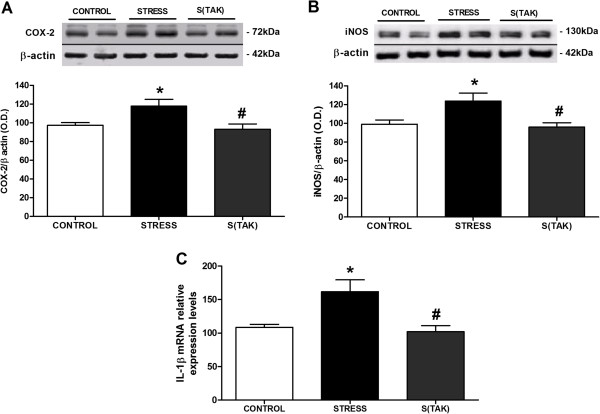
Anti-inflammatory effects of systemic TAK-242 after stress exposure in rat brain frontal cortex. Western blot detection of the pro-inflammatory enzymes (A) inducible cyclooxygenase (COX-2) and (B) inducible nitric oxide synthase (iNOS), and densitometric analysis of the respective bands of interest in brain cortex samples from control (CONTROL) and stressed rats with TAK-242 (S(TAK)) or without TAK-242 (STRESS). The densitometric data of the respective band of interest are normalized by β-actin (lower band). In A and B, the data are representative of two experiments (n = 3 to 4 per group in each experiment). One-way analysis of variance followed by Newman–Keuls post hoc test. *P < 0.05 versus control; #P < 0.05 versus stress. O.D., optical density. (C) IL-1β mRNA relative levels in brain frontal cortex samples of control and stressed rats with or without TAK-242 (S(TAK) and STRESS, respectively). mRNA data are normalized by tubulin. Data represent the mean ± SEM (n = 4 to 5 per group). One-way analysis of variance followed by Newman–Keuls post hoc test. *P < 0.05 versus control #P < 0.05 versus stress.